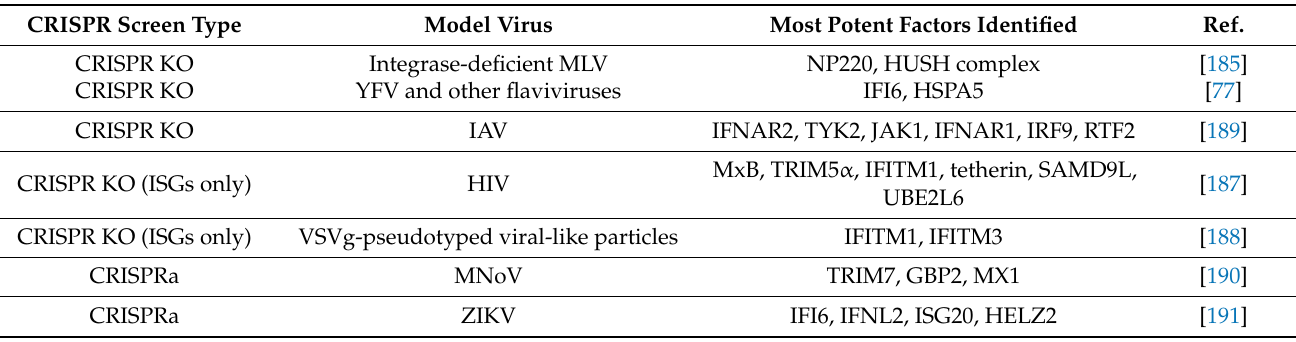
Table 3. Major screening studies of host antiviral restriction